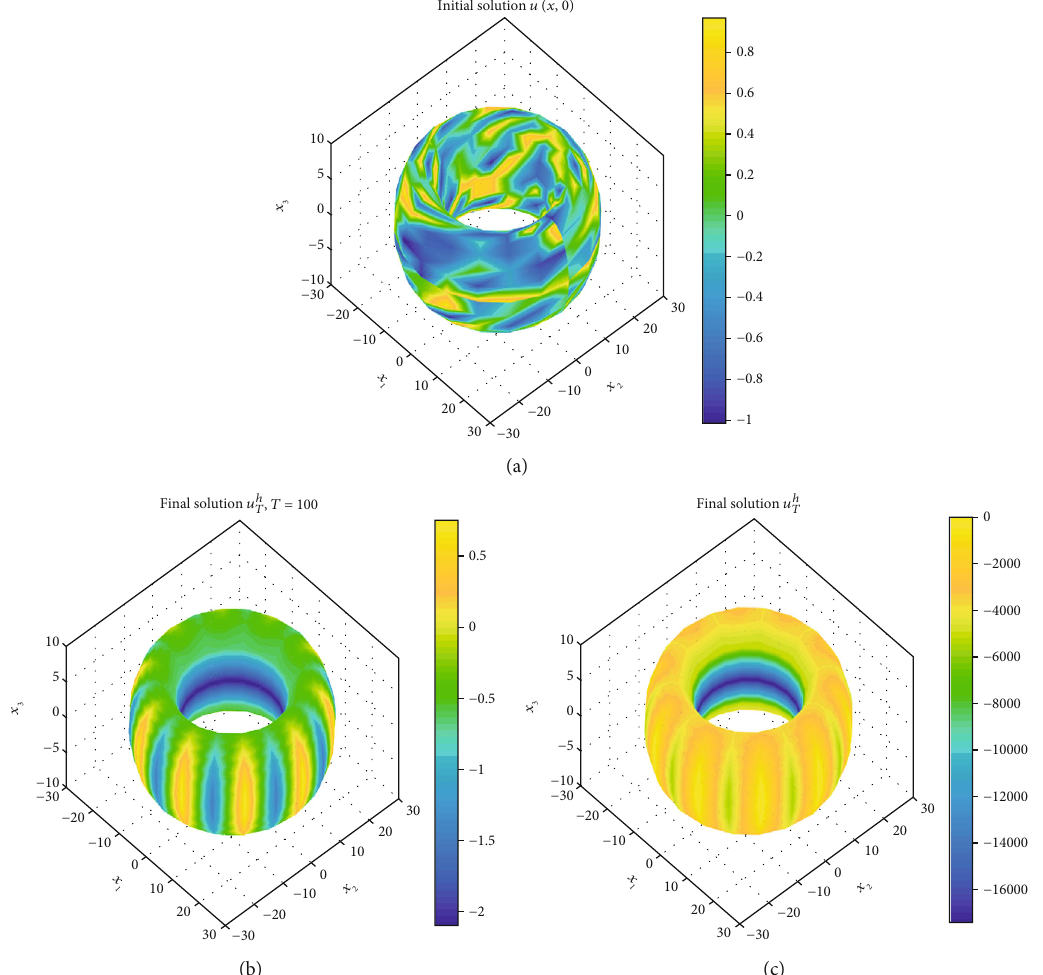
= 100 . (c) Final distribution u at T = 300 . Case: equation (21), D